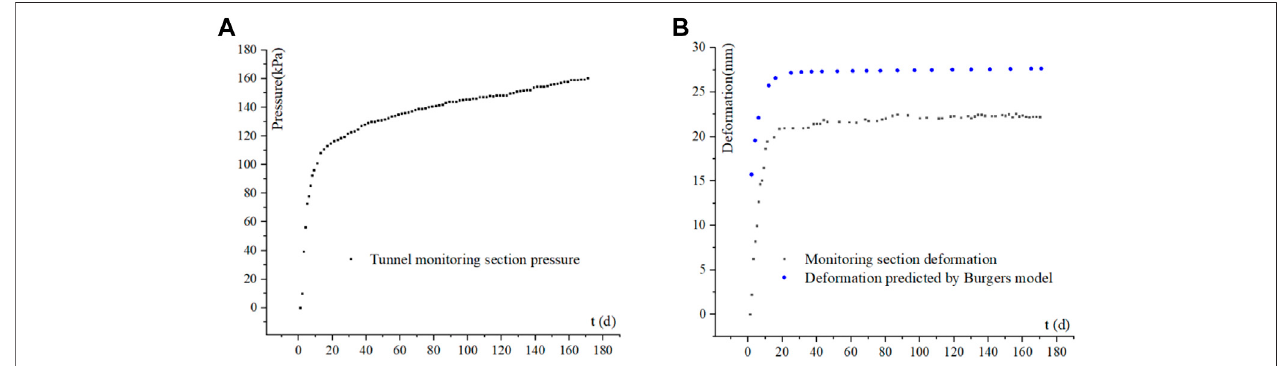
FIGURE 7 | Monitored pressure and strain vs. time. (A) Monitored Pressure results vs. time. (B) Monitored strain results and simulated strain results by the Burgers model.